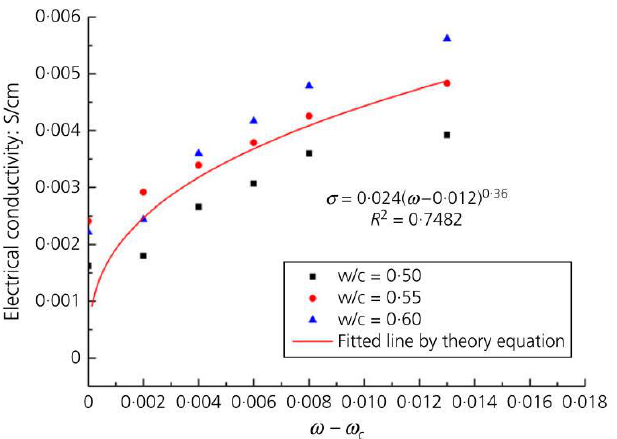
Figure 25. Experimental validation of percolation theory. Reprinted with permission from Ref. [43].